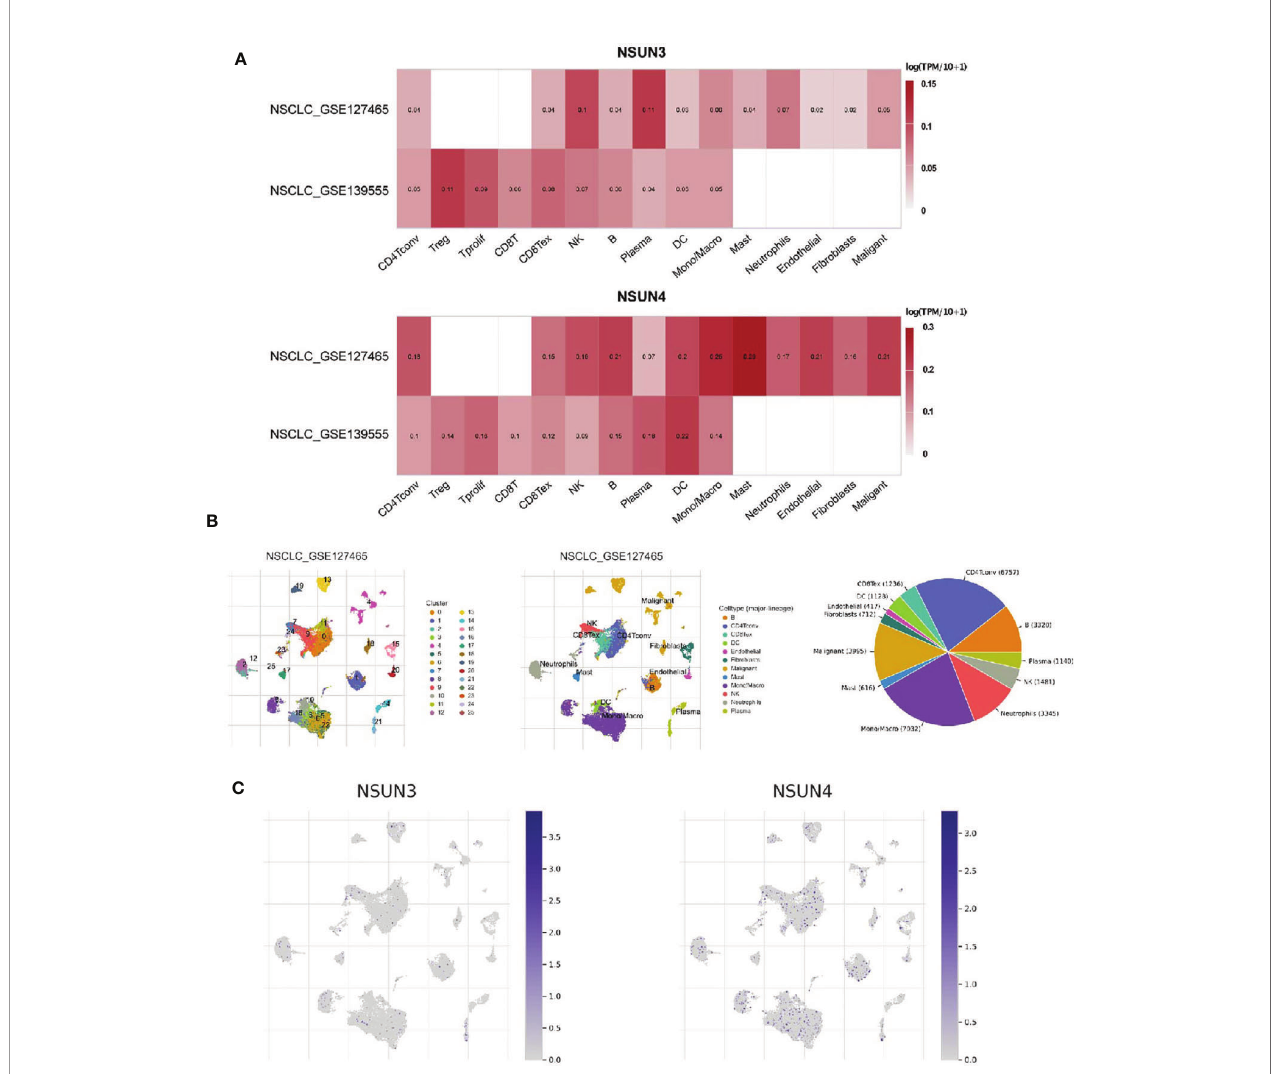
FIGURE 7 | Expression of m5C regulators in tumor microenvironment-related cells (TISCH). (A) The expression levels of NSUN3 and NSUN4 in the tumor microenvironment-related cells of lung squamous cell carcinoma in the GEO dataset. (B) Annotation of all cell types in GSE127465 and the percentage of each type of cell. (C) The proportion of NSUN3 and NSUN4 in GSE127465 in various types of